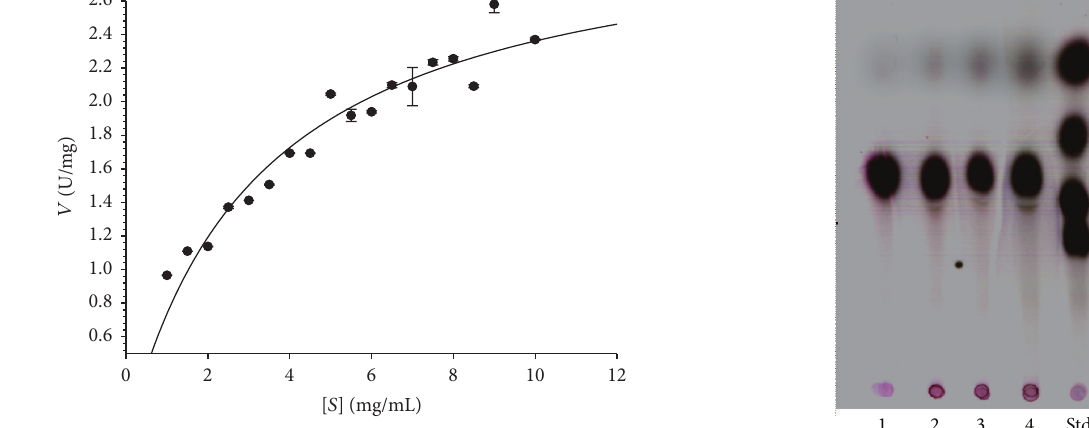
Figure 4: Effects of substrate concentration on the velocity of the cyclodextrinase of CDase-Tk. Assays were performed as described in the Materials and Methods. The parameters reported here are the means of three determinations.